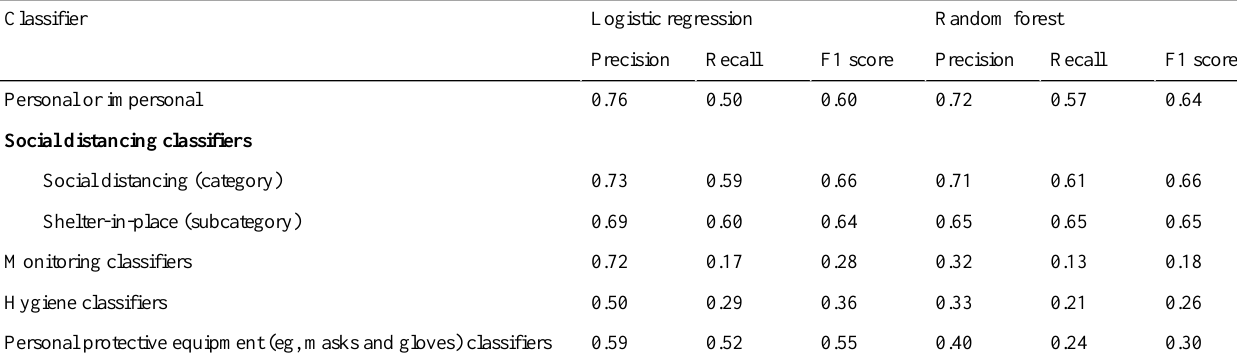
Table 2. Tweet classification results.